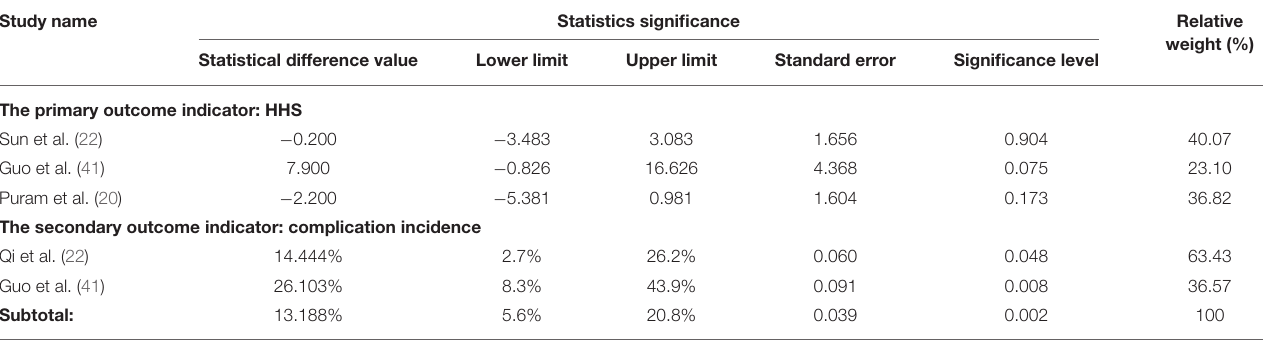
TABLE 5 | Statistical significance of two outcome indicators of included